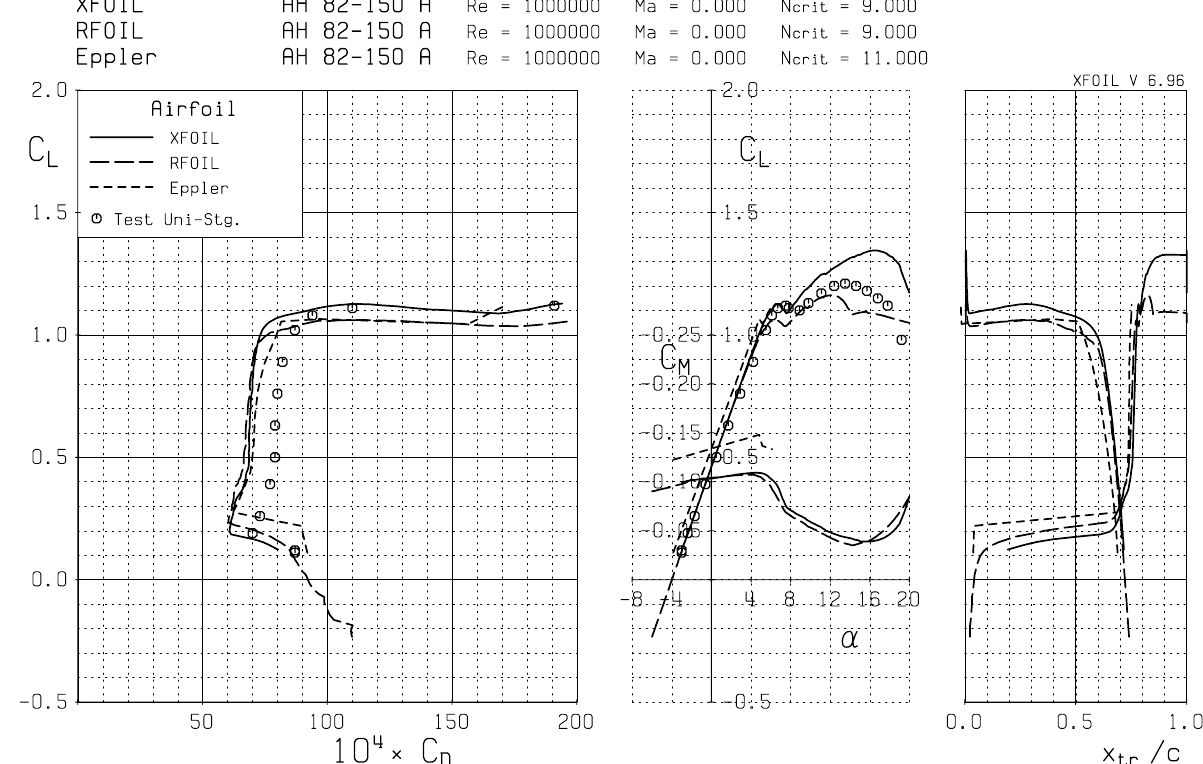
Fig 10. Comparison of calculated and measured data of AH82-150A airfoil at Re = 1·10